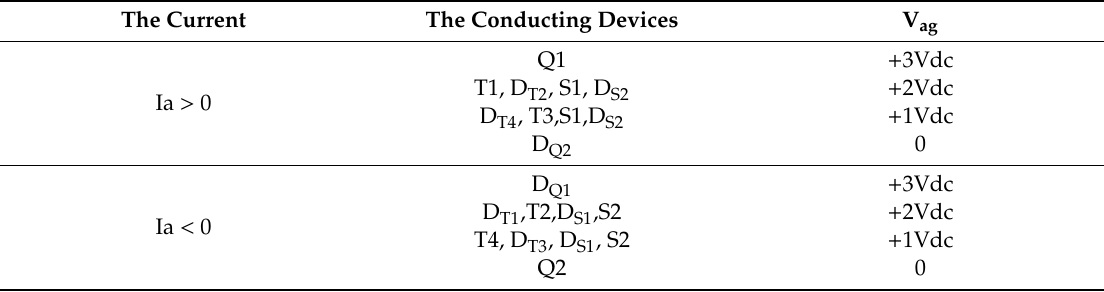
Table 6. Conducting devices of the 4LT 2 C for phase a